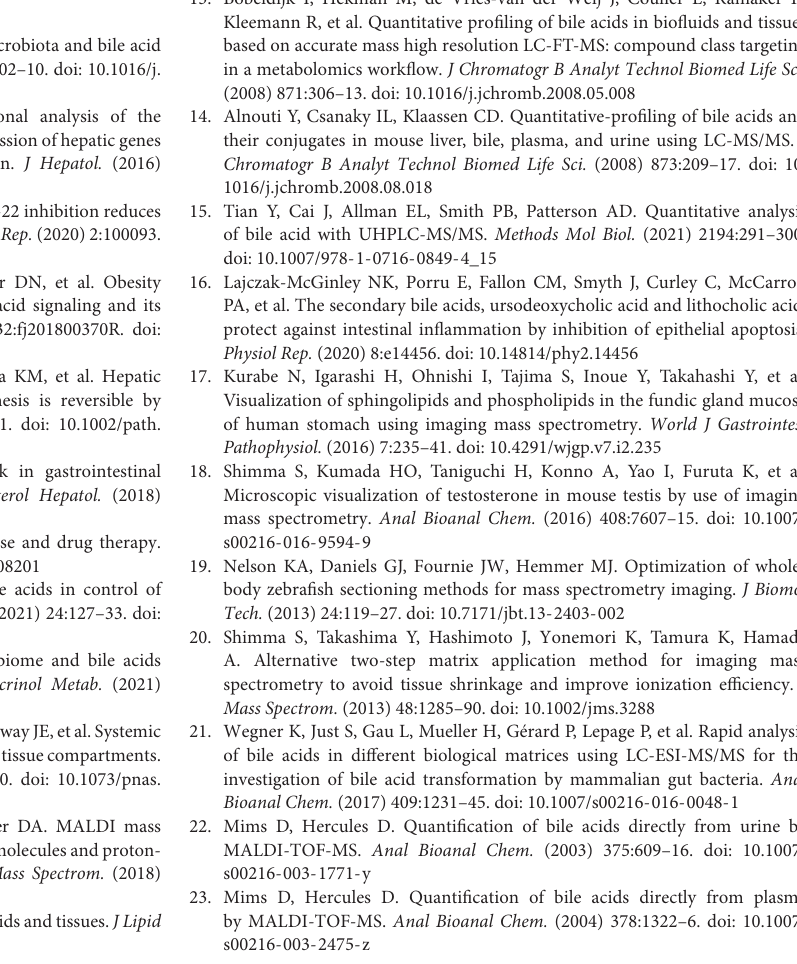
Supplementary Figure 5 | MALDI-MSI single pixel mass spectra from liver tissue and average peak intensity ratio of BAs. ∗∗ p < 0.01, ∗∗∗ p < 0.001 versus CD group ( n ge 6). Supplementary Figure 6 | MALDI-MSI single pixel mass spectra from ileum tissue and average peak intensity ratio of BAs. ∗∗ p < 0.01, ∗∗∗ p < 0.001 versus CD group ( n ge 6). Supplementary Figure 7 | MALDI-MSI single pixel mass spectra from colon tissue and average peak intensity ratio of BAs. ∗ p < 0.05, ∗∗ p < 0.01, ∗∗∗ p < 0.001 versus CD group ( n ge